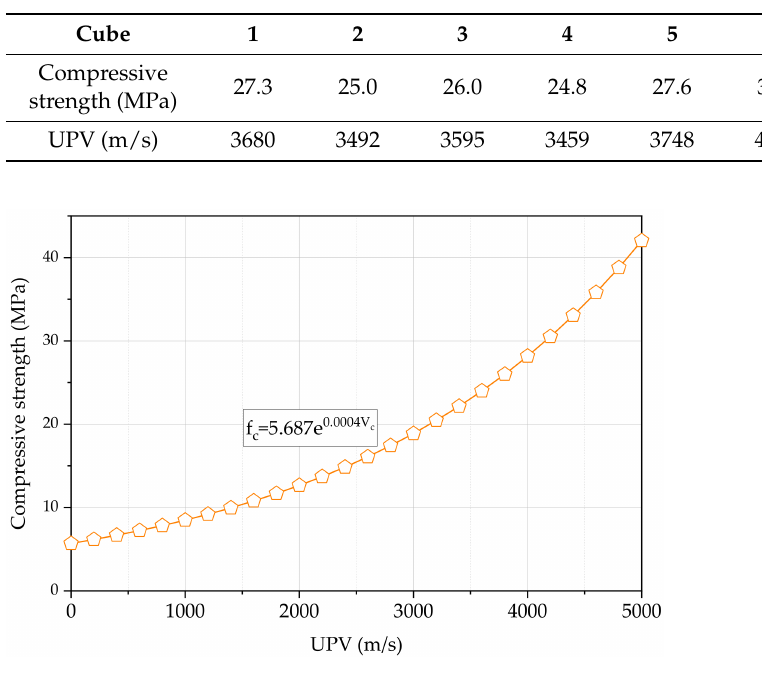
Table 4. Measured cube compressive strength and UPV data at 28 days.